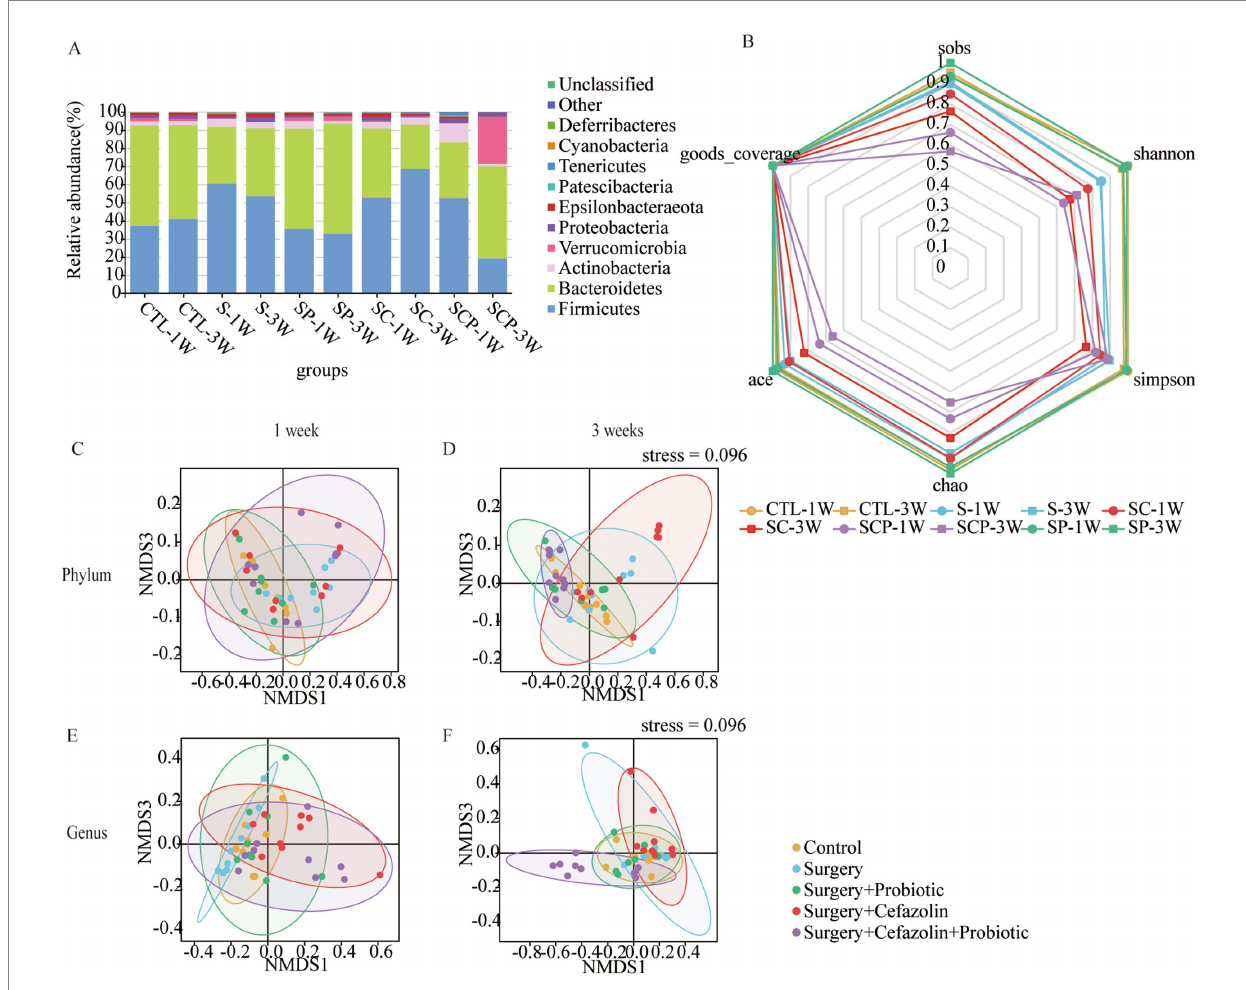
FIGURE 7 The probiotics administration for restoring surgery/anesthesia stress-induced and perioperative cefazolin-induced gut dysbacteria, respectively. (A) The intestinal microbiome composition in the phylum level at 1 and 3 weeks of Grp CTL, Grp S, Grp SP, Grp SC, and Grp SCP. (B) The radar graph of alpha diversity of gut microbiome of Grp CTL, Grp S, Grp SP, Grp SC, and Grp SCP at 1 and 3 weeks. (C–F) NMDS analysis for beta diversity of gut microbiome: comparison between intra-group and inter-group Bray-Curtis distance of gut microbiome in the phylum level or genus level at 1 or 3 weeks of Grp CTL, Grp S, Grp SP, Grp SC, Grp SCP. Grp, group; CTL, control; S, surgery; SC, surgery combined with cefazolin; SP, surgery combined with probiotics; SCP, surgery combined with cefazolin and probiotics; NMDS, non-metric multi-dimensional